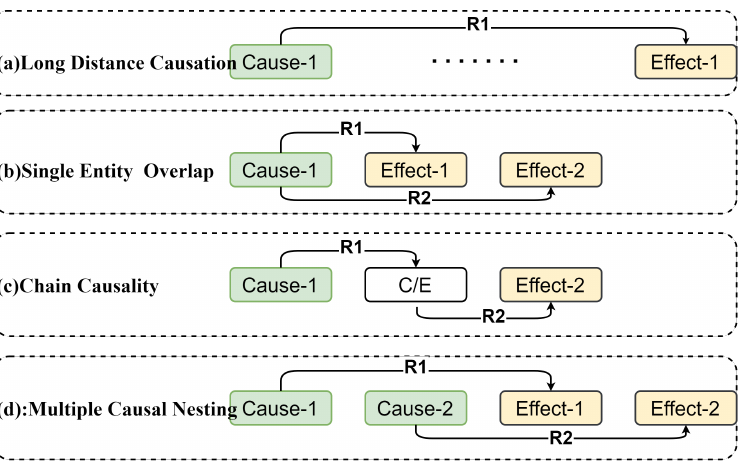
Figure 2. Schematic diagram of complex cause–effect